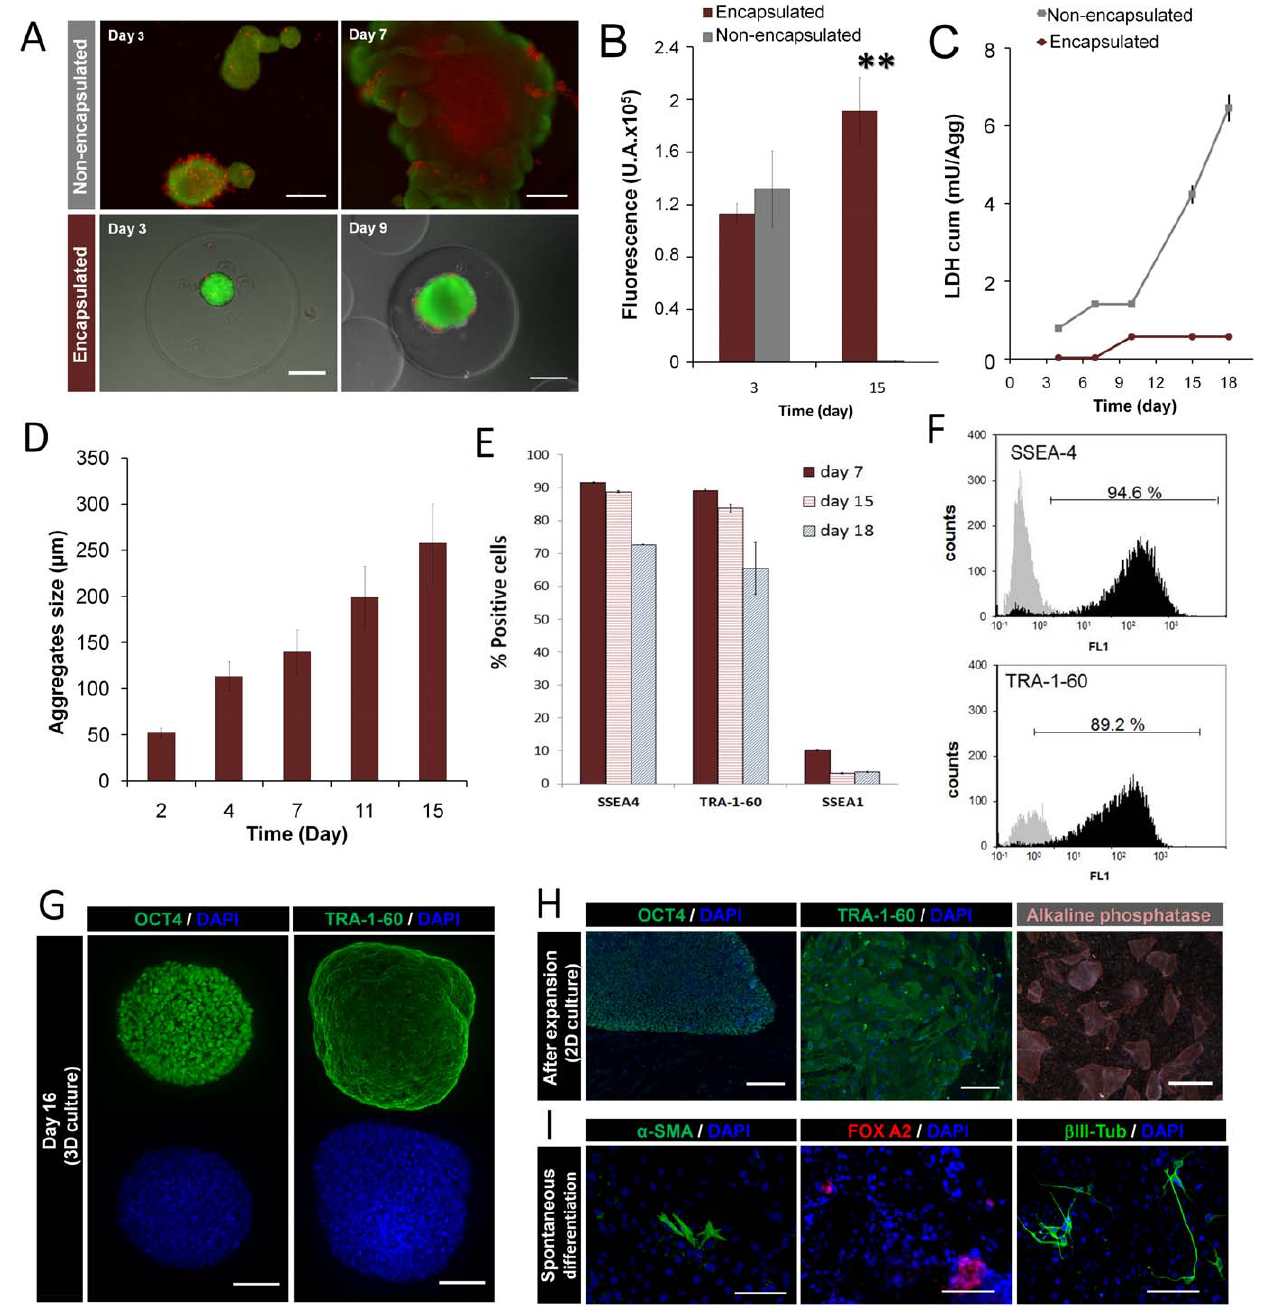
Figure 2. Effect of alginate microencapsulation on the expansion of hESC as aggregates. hESC aggregates were encapsulated at day 2 and cultured in spinner vessels. ( A ) Phase contrast and fluorescence images of encapsulated and non-encapsulated cultures at days 3, 7 and 9. Viability of hESC aggregates assessed by staining with fluoresceine diacetate (FDA-live cells, green) andpropidium iodide (PI- dead cells, red). Scale bar: 100 m m. ( B– C ) Cell growth performance of both encapsulated (purple) and non-encapsulated (grey) cultures. ( B ) Metabolic activity measured by alamarBlue test on the day after microencapsulation (day 3) and at day 15. Error bars denote SD of 3 measurements. ** indicates significantdifference (P , 0.05) in metabolic activity by one-way ANOVA analysis. ( C ) Cumulative values of specific rates of LDH release overtime. Error bars denote SD of 3 measurements. ( D ) Aggregate size of encapsulated cultures at days 2, 4, 7 and 15 of culture. Error bars denote SD of 10 measurements. ( E–I ) Characterization of encapsulated hESC aggregates expanded in spinner vessels. ( E ) Percentage of SSEA-4, TRA-1-60 and SSEA-1 positive cells at days 7 (purple bars), 14 (pink stripes bars) and 21 (grey stripes bars). Error bars represent SD of 2 measurements. ( F ) Flow cytometry analysis of SSEA-4 and TRA-1-60 positive cells at day 7 of culture. ( G ) Confocal images of aggregates labeled for Oct-4 and TRA-1-60 at day 16 of 3D culture. Scale bar: 50 m m. ( F–G ) Flow cytometry analysis of the expanded population ( H ) Immunofluorescence images of Oct-4 and TRA-1-60 labeling and phase contrast pictures of alkaline phosphatase (AP) activity, staining after expansion (2D culture). Nuclei were labeled with DAPI (blue). Scale bars: immunofluorescence images - 200 m m, AP image 2 1 mm. ( I ) In vitro pluripotency analysis. Microcapsules were dissolved and hESCs were transferred to a monolayer of inactivated hFF. At confluence, colonies were dissociated and hESCs were able to form embryoid bodies (EBs) in non-adherent conditions and differentiated into cells from all three germ layers. Fluorescence images of differentiated cultures labeled for a –SMA ( a smooth muscle actin, mesoderm), FOX-A2 (Forkheadbox A2, endoderm) and b III-Tub ( b tubulin type III, ectoderm). Nuclei were stained with DAPI (blue). Scale bar: 100 m m. doi:10.1371/journal.pone.0023212.g002 PLoS ONE |